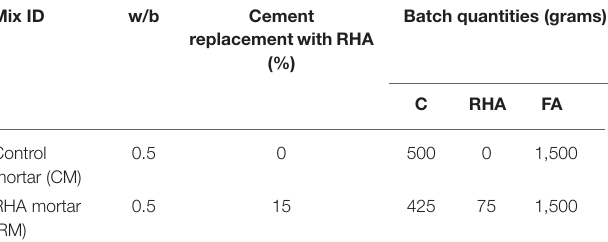
TABLE 7 | Mix proportion of cement sand mortars.